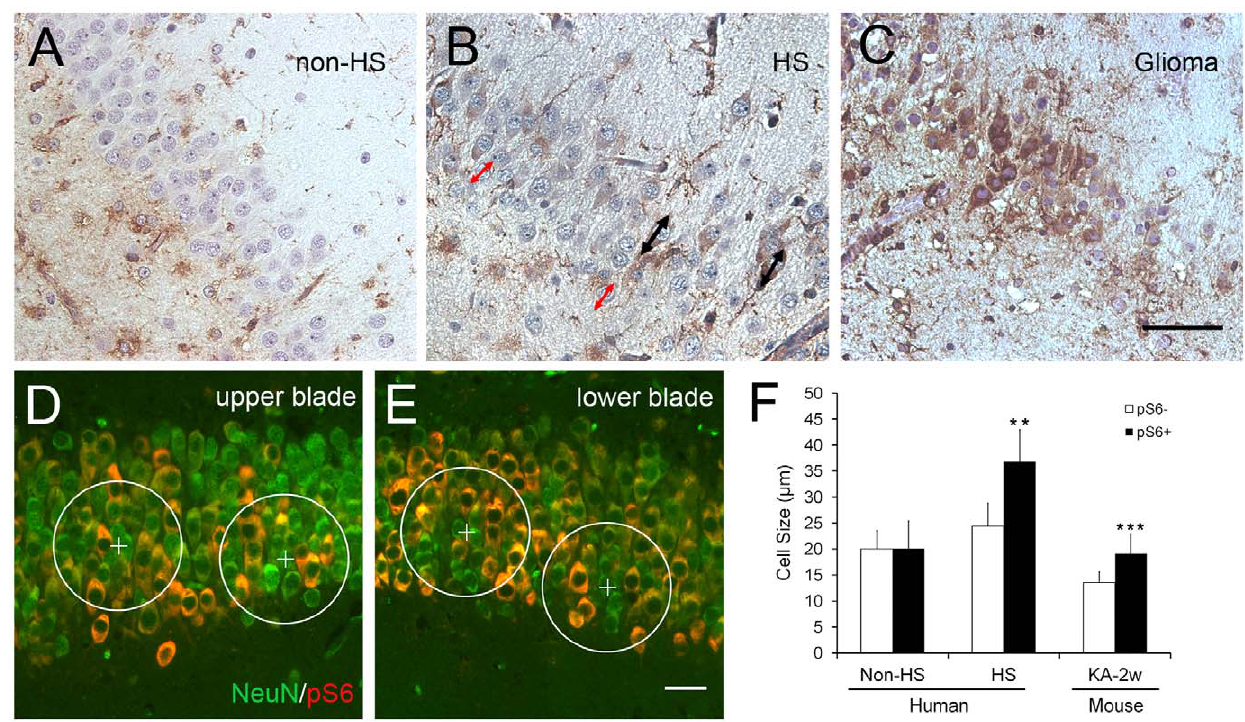
Figure 5. pS6 IR in hippocampus 2 and 5 weeks after KA-induced seizures. (A) Dispersion of granule cells is visible at 2 weeks post-SE ipsilateral (ipsi) to the KA injection (n=4), (C) and is pronounced at 5 weeks (n=5). pS6 is significantly upregulated in most of the dispersed granule cells at 2 weeks (A), and in the entire dentate gyrus at 5 weeks (B). The morphology and pS6 IR in the corresponding non-injected (contralateral, conr) hippocampus are normal (B, D). Immunofluorescence for pS6 (green) confirms the same observations. (Insets in C, D). Astrocyte-like cells with increased pS6 IR are widespread in the dentate gyrus and CA area of sclerotic hippocampus (Arrows in A, C). Scale bar in A–B: 400 m m.